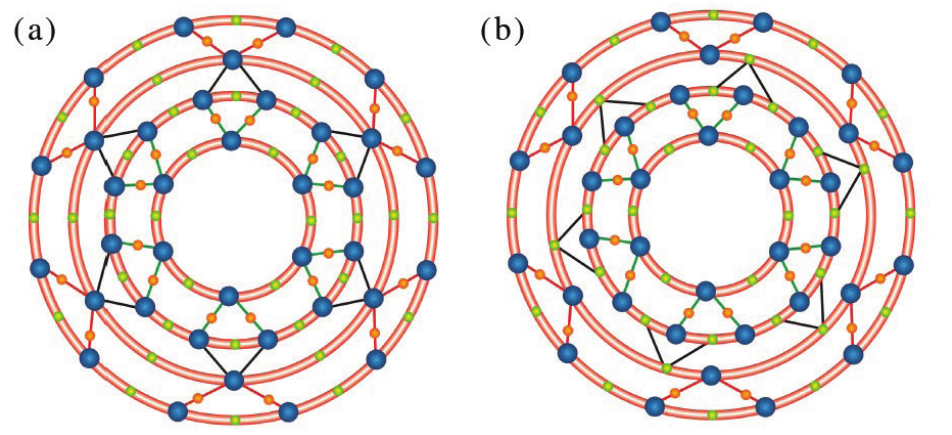
Figure 2: (a) First metal-organic network (MON